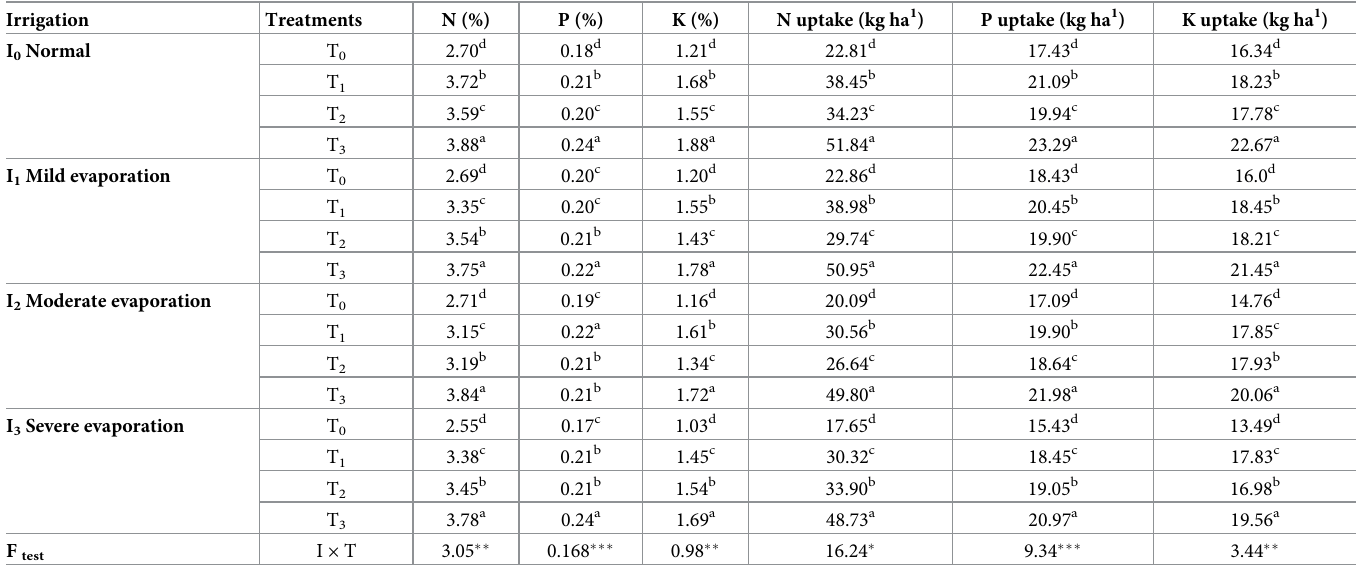
Table 6. Variation in nitrogen (n), phosphorus (p) and potassium (k) of canola with chemical fertilizers and plant growth regulators under different water regimes. Irrigation